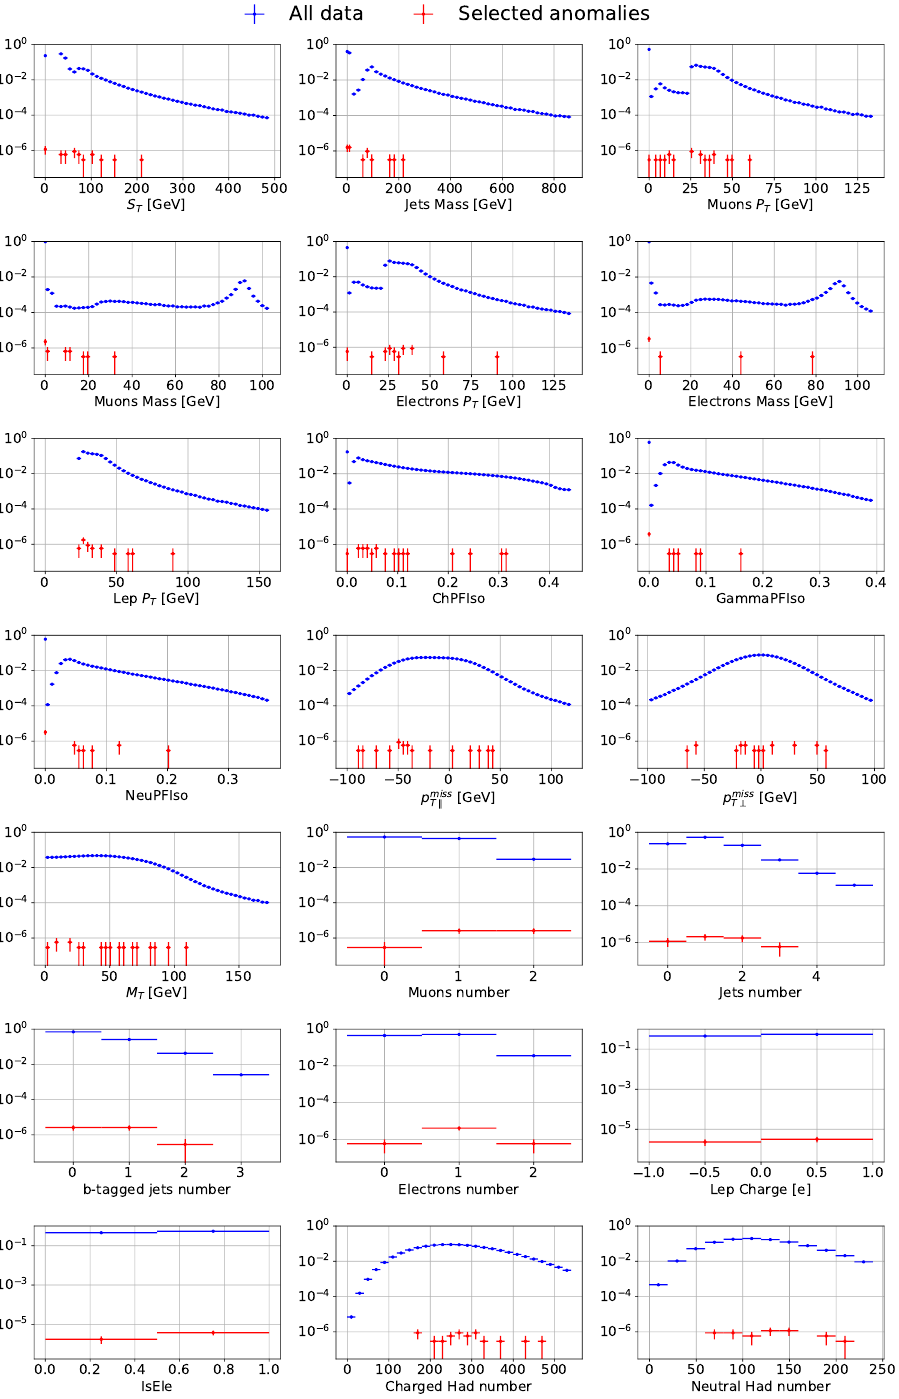
Figure 8 . Comparison between the input distribution for the 21 HLF of the validation dataset (blue histograms) and the distribution of the SM outlier events selected from the same sample by applying the Loss reco threshold (red dots). The outlier events cover a large portion of the HLF de(cid:12)nition range and don’t cluster on the tails.